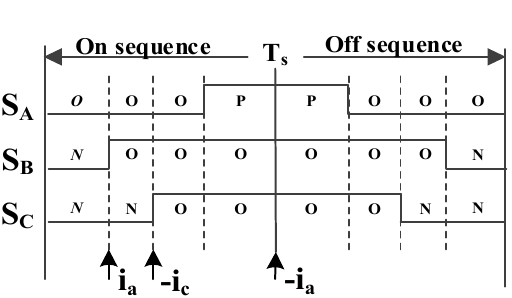
Figure 5. One period of the SVPWM method and sampling point.